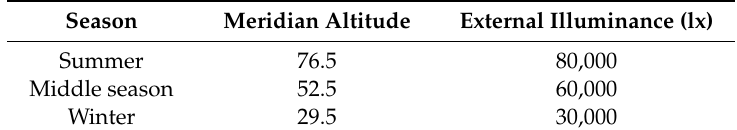
Figure 5. Cross ‐ section and plane of testbed and sensor location. Table 4. Configuration of meridian altitude of the sun and external illuminance for summer, middle season, and winter.